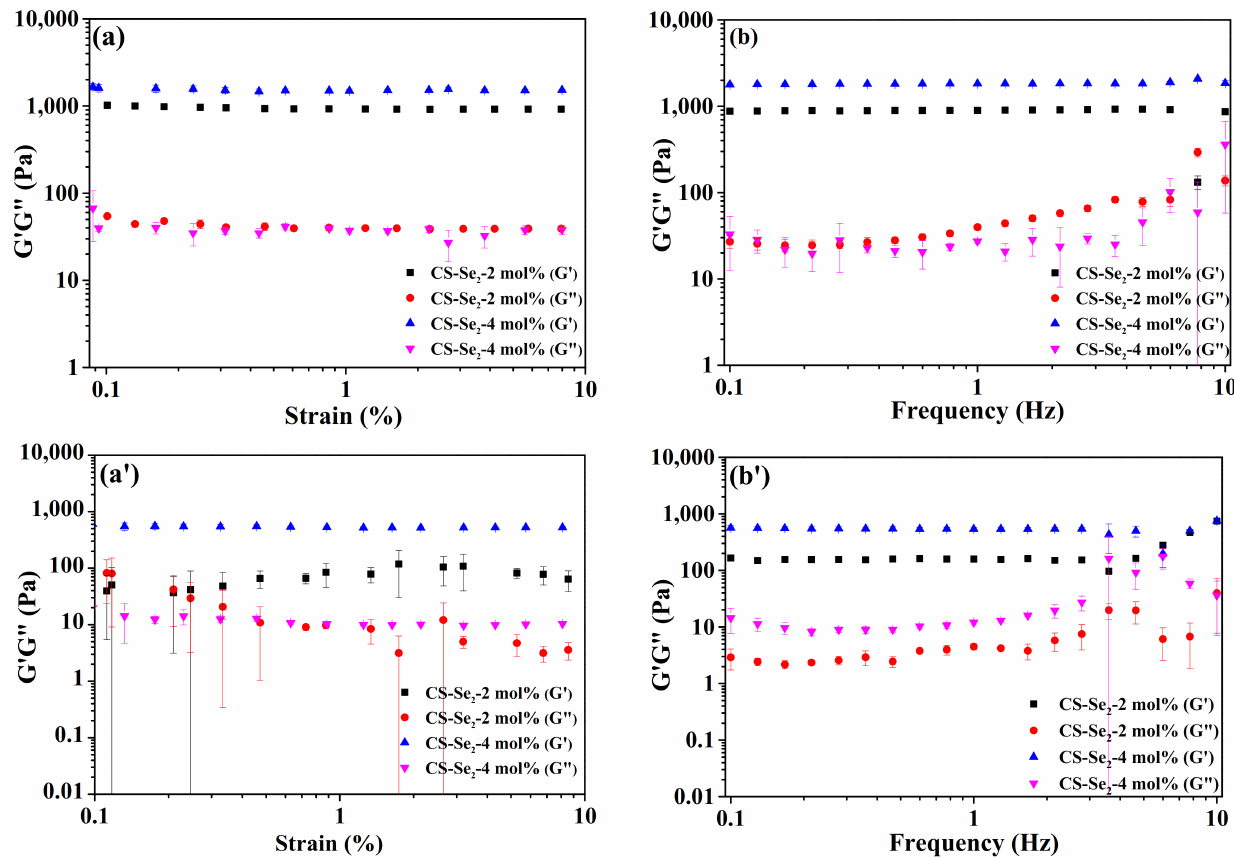
Figure 3. Oscillatory strain and frequency sweeps on 2 and 4 mol% Se-containing chitosan hydrogels. ( a , b ) for 3 wt % hydrogels; ( a’ , b’ ) for hydrogels after swelling for 12 h.